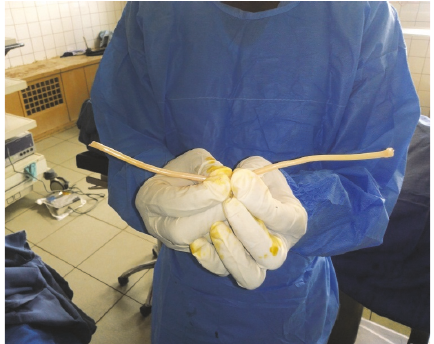
Figure 2: Foreign body after